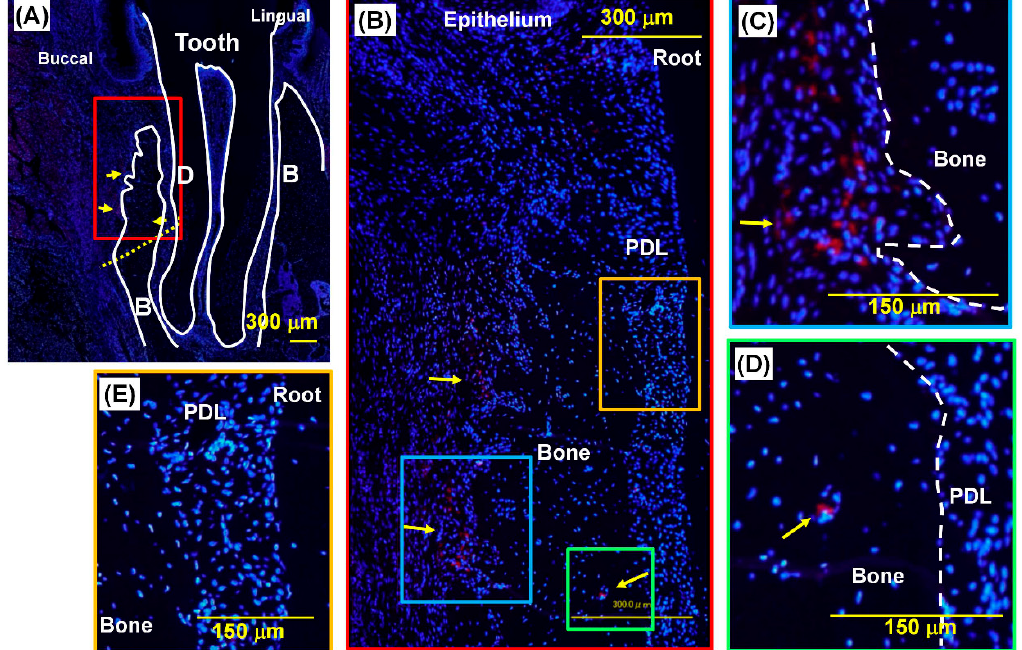
Figure 4. Localization of PKH26-labeled PDLSC in regenerated periodontal tissues. Fluorescence microscopic images of periodontal tissues four weeks after transplantation. Lower magnification image of the section ( A ). Close-up image of the red box area in panel ( A )is shown in panel ( B ). Higher magnified images of the blue, green, and blue boxed areas are demonstrated in panels ( C – E ), respectively. The yellow and white dotted lines denote the bottom of created periodontal defect and bone surface, respectively. Red fluorescence signals are derived from PKH26, which was used for labeling of transplanted PDLSCs, and blue signals are from DAPI nuclear staining. PKH2-positive cells were observed in limited areas in periodontal tissues, as indicated by the yellow arrows, at the outer surface of bone and incorporated in blood vessel. The center area of regenerated PDL did not contain PKH26-positive cells. Yellow arrow: PKH26-positive cells, B: bone, D: dentin, PDL: periodontal ligament.